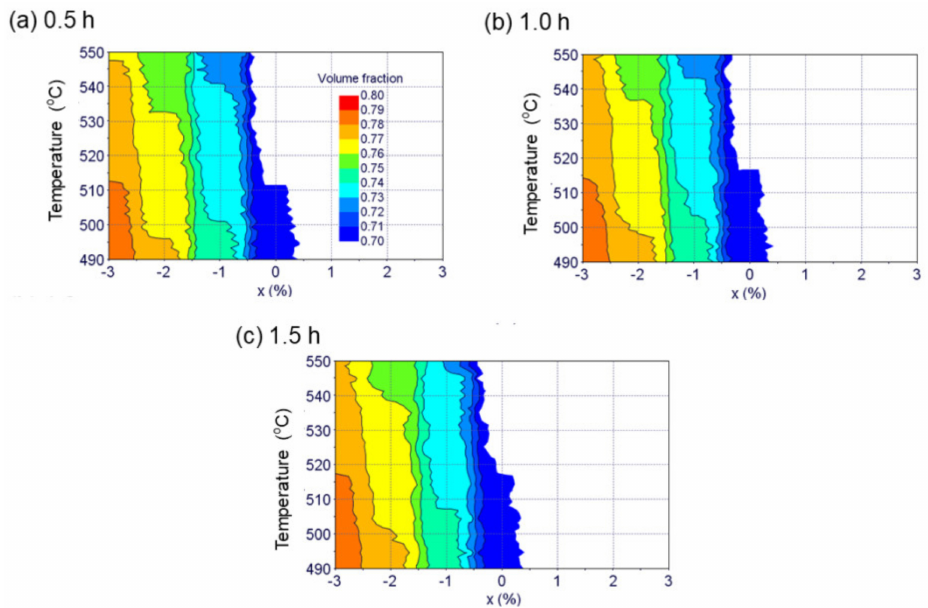
Figure 7. Example of volume fractions of nanocrystalline phase predicted after distinct periods of annealing time (( a ): 0.5 h; ( b ): 1.0 h; ( c ): 1.5 h) as a function of different Fe and Si (x %) content [23]. Reprinted with permission from